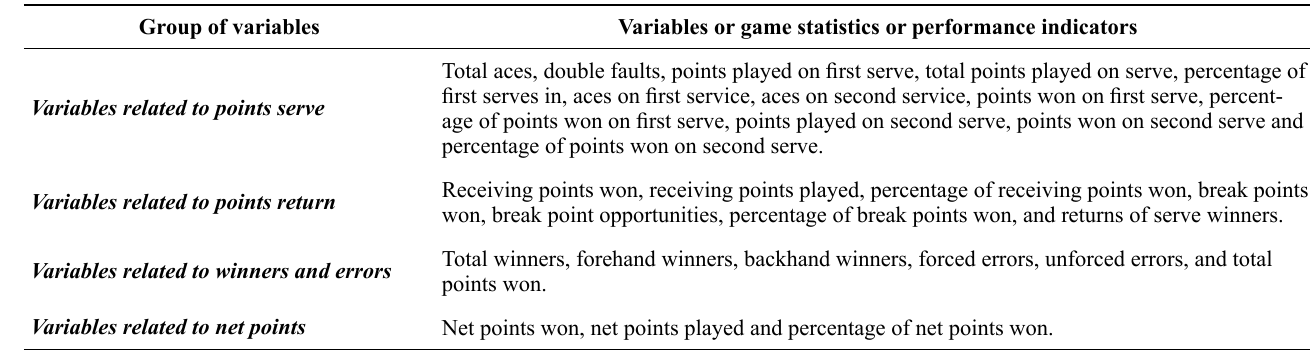
Table 1. Variables studied in the wheelchair tennis competition from the Paralympics Games London 2012. Group of variables Variables or game statistics or performance indicators